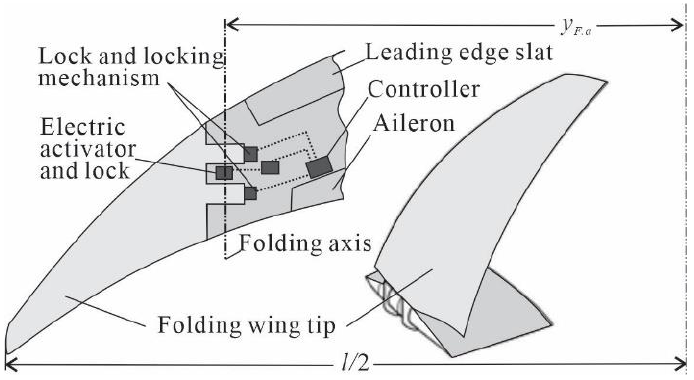
Figure 5. The layout of the wingtip folding system [42].